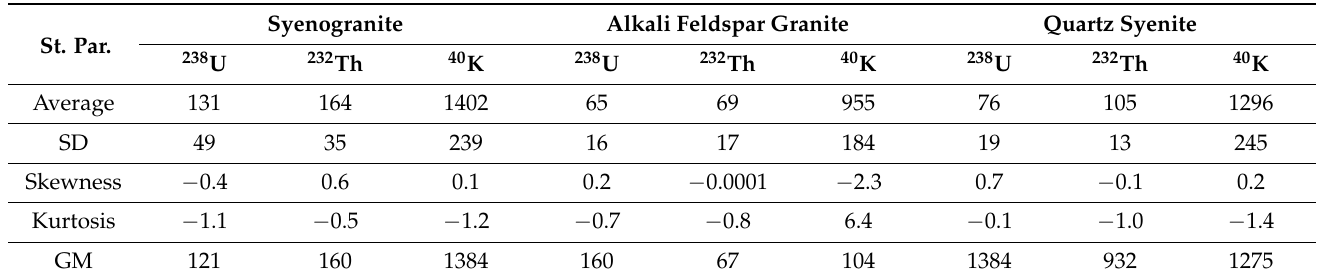
Table 4. Statistics for the corresponding data for 238 U, 232 Th and 40 K activity concentrations in the